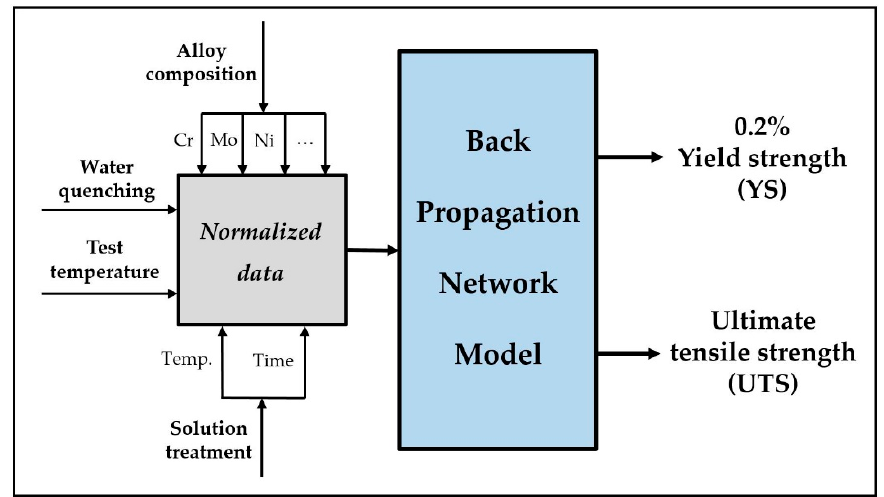
Figure 2. Schematic diagram of Back Propagation Neural Network (BPNN) model for predicting two tensile properties of austenitic stainless steels in this study.